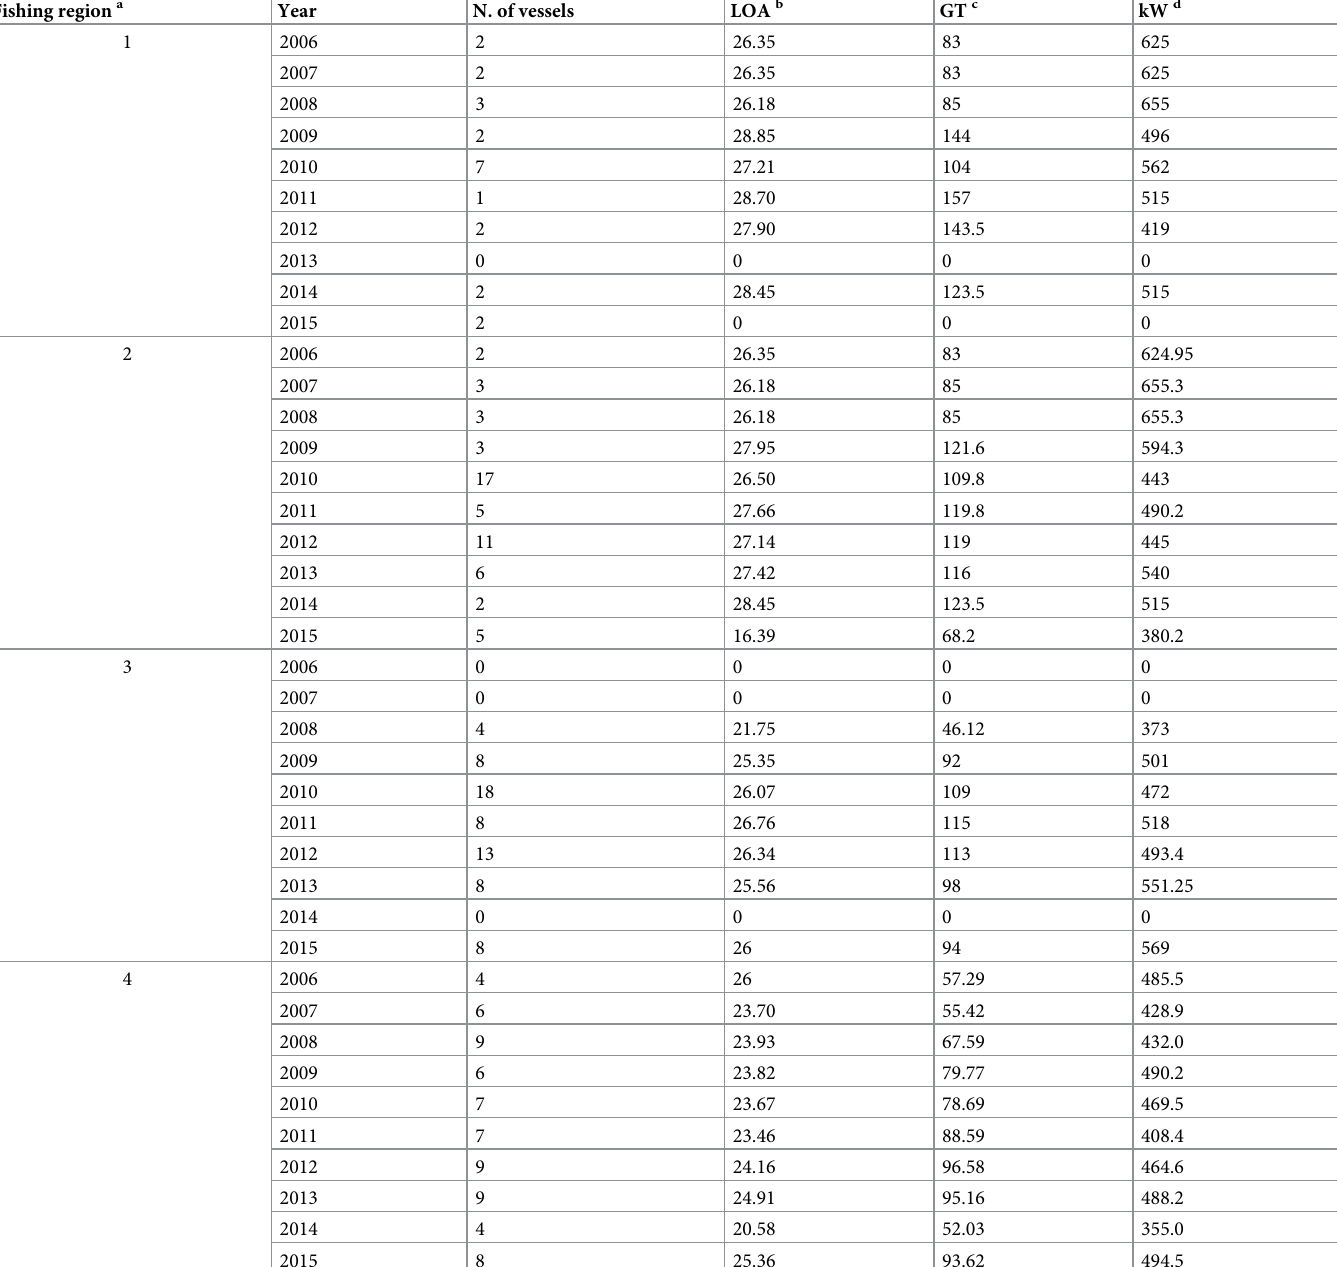
Table 1. Average of Italian pelagic trawlers monitored between 2006 and 2015 in five different fishing regions (1–5) in the northern central Adriatic Sea. Average vessel characteristics (LOA, GT and kW) are also indicated. Fishing region